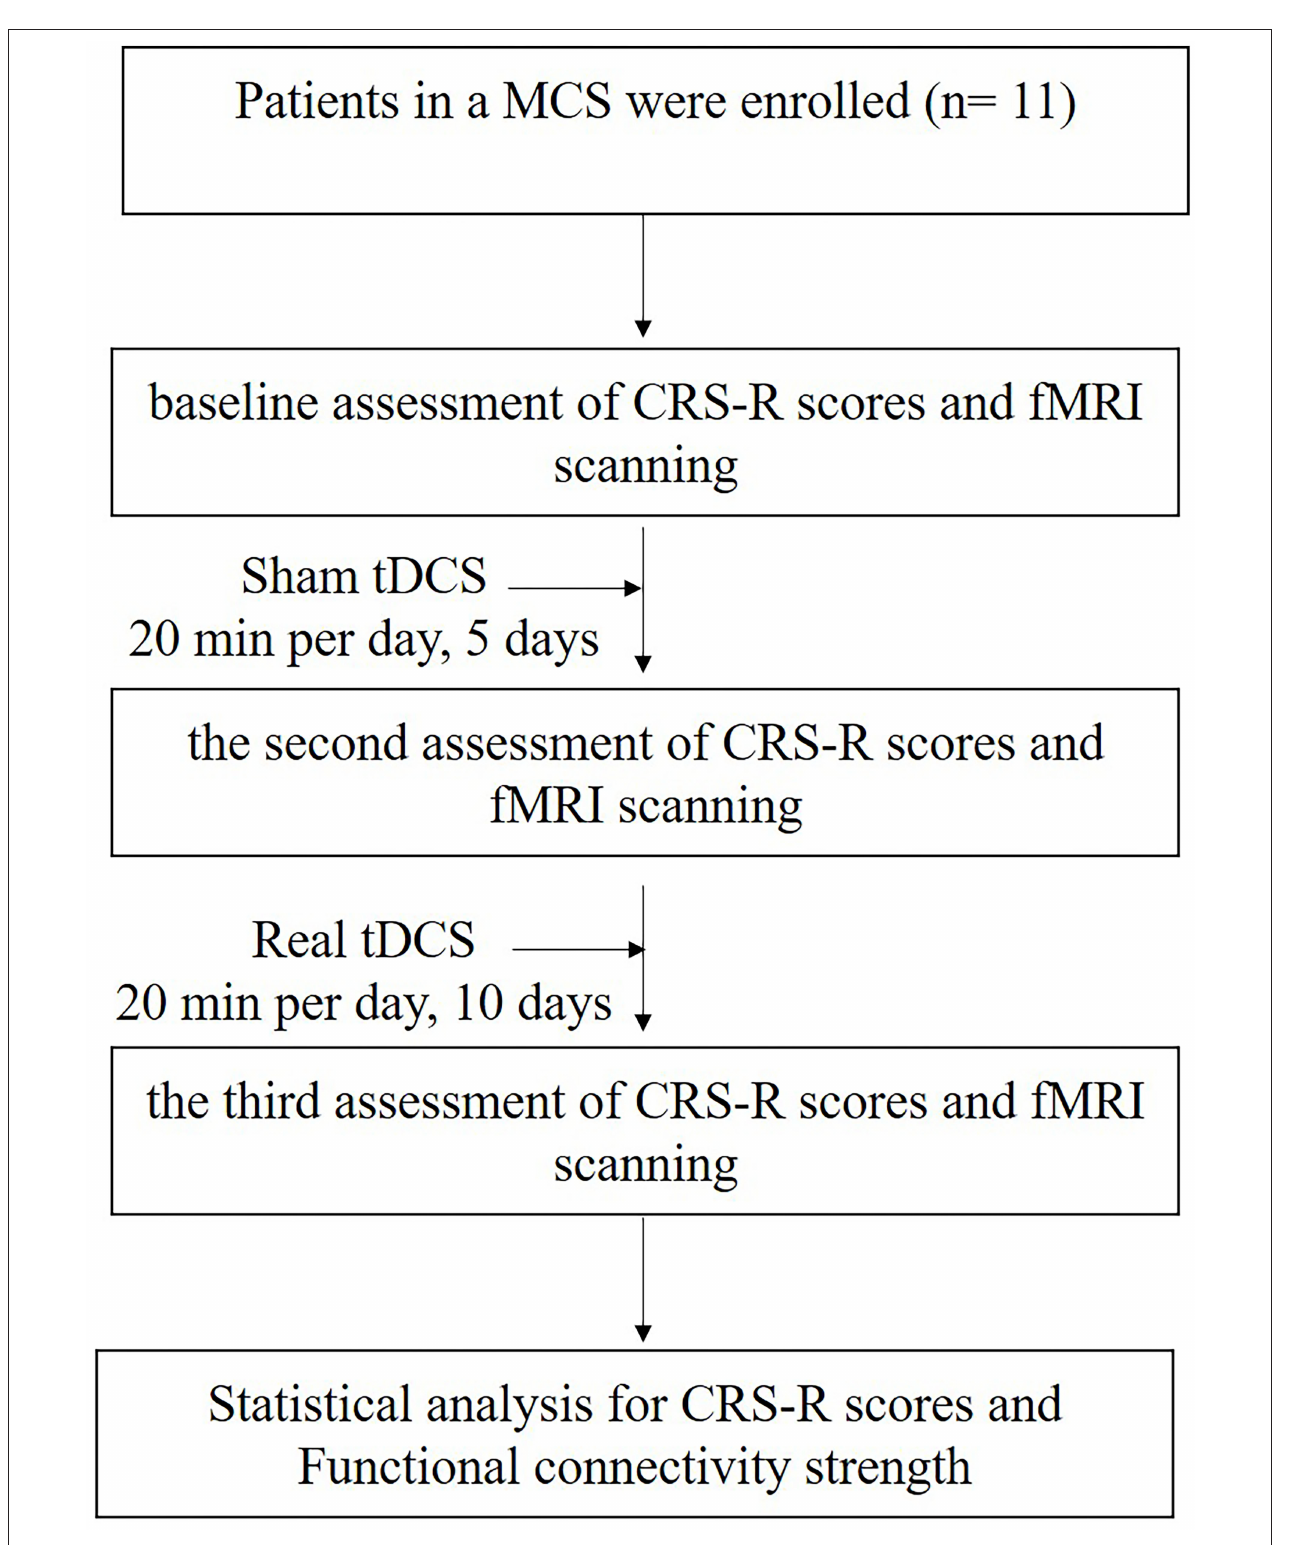
FIGURE 1 | A flow chart illustrating the process for the study. MCS, minimally conscious state; tDCS, transcranial direct current stimulation; CRS-R, Coma Recovery Scale-Revised.